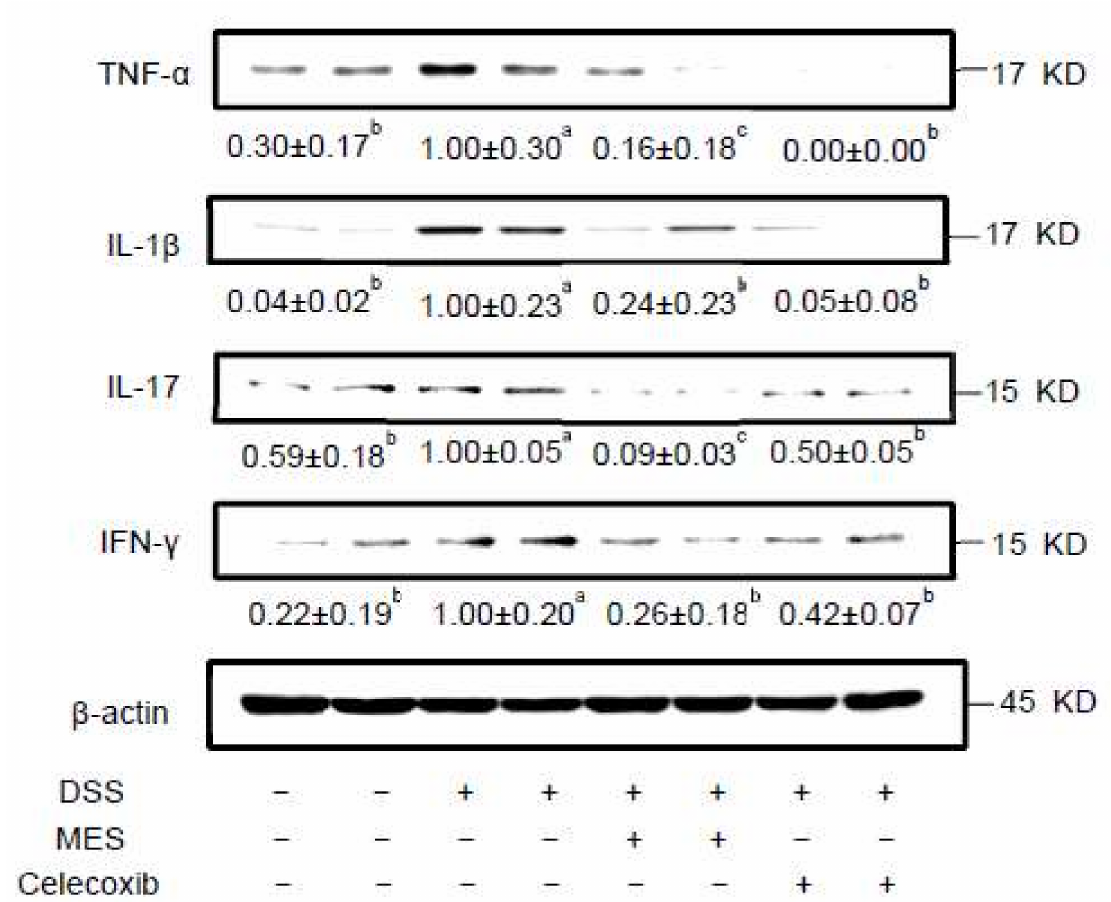
Figure 4. MES supplementation suppresses levels of pro-inflammatory cytokines in colon of DSS induced colitis mice. Protein levels of TNF- α , IL-1 β , IL-17 and IFN- γ were determined by Western Blot. All data are expressed as mean ± SD. Bars with no common letters are significantly different ( p < 0.05). DSS: dextran sulfate sodium; MES: meroterpenoid-rich ethanoic extract of a brown algae, Sargassum macrocarpum